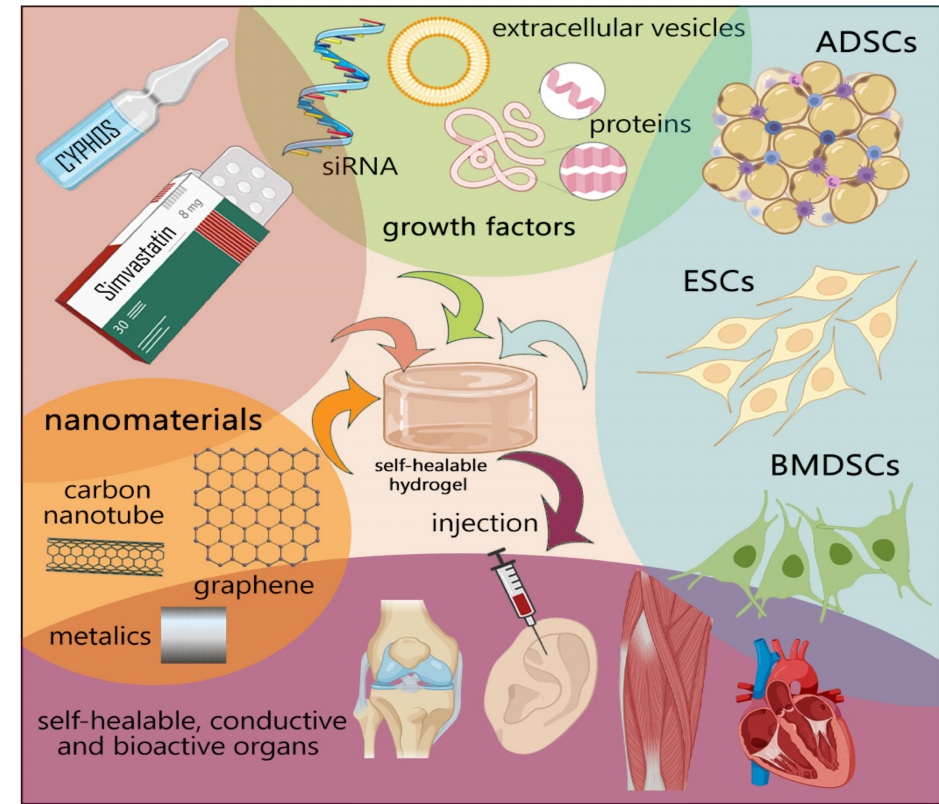
Figure 2. Broad overview on tissue engineering. Tissue engineering contributes to cell therapies, gene editing, genetic manipulation, and nanomedicine.